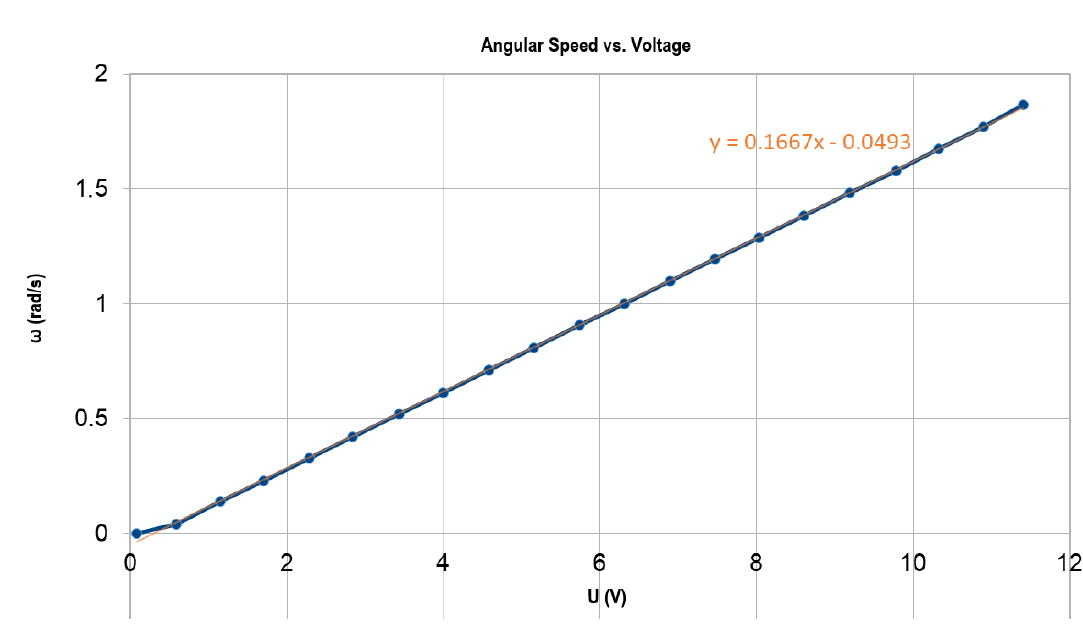
Figure 7. Plot of Angular Speed vs.